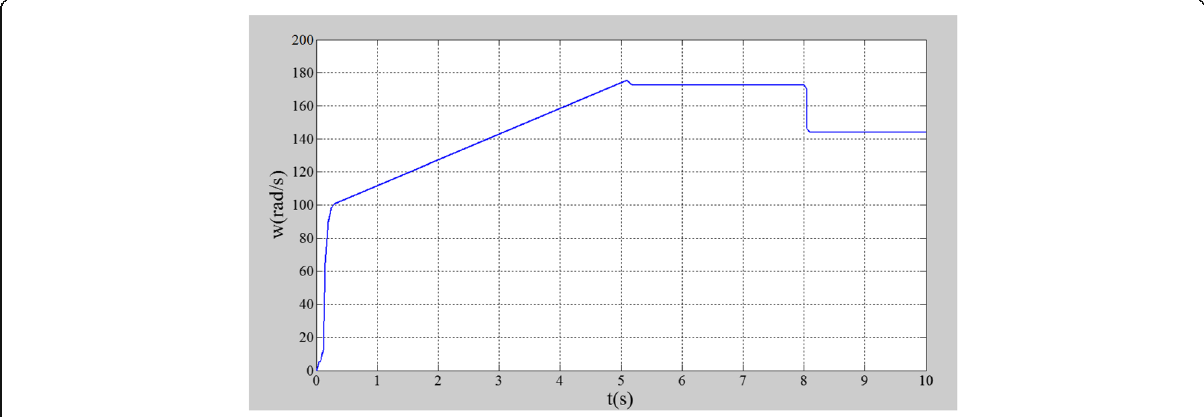
Fig. 8 Outer rotor speed of the double rotor speed-regulating generator. In Fig. 8, X -axis is time (s) and Y -axis is outer rotor speed (rad/s)